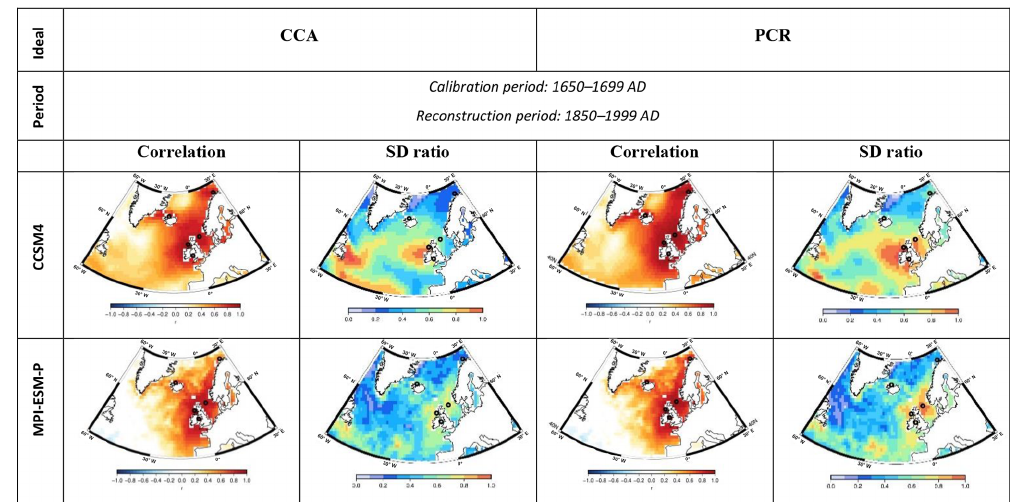
Figure 2. Correlation coefficient (first and third column) and SD ratio (second and fourth column) between the reconstructed and the original SST anomaly evolution of the NA field during the industrial era. The results regard the ideal experiment and are given for the LIA calibration period (1650—1699 AD) and for the two different reconstruction methods (first and second column CCA, third and fourth column PCR) for the models CCSM4 (first row) and MPI-ESM-P r1 (second